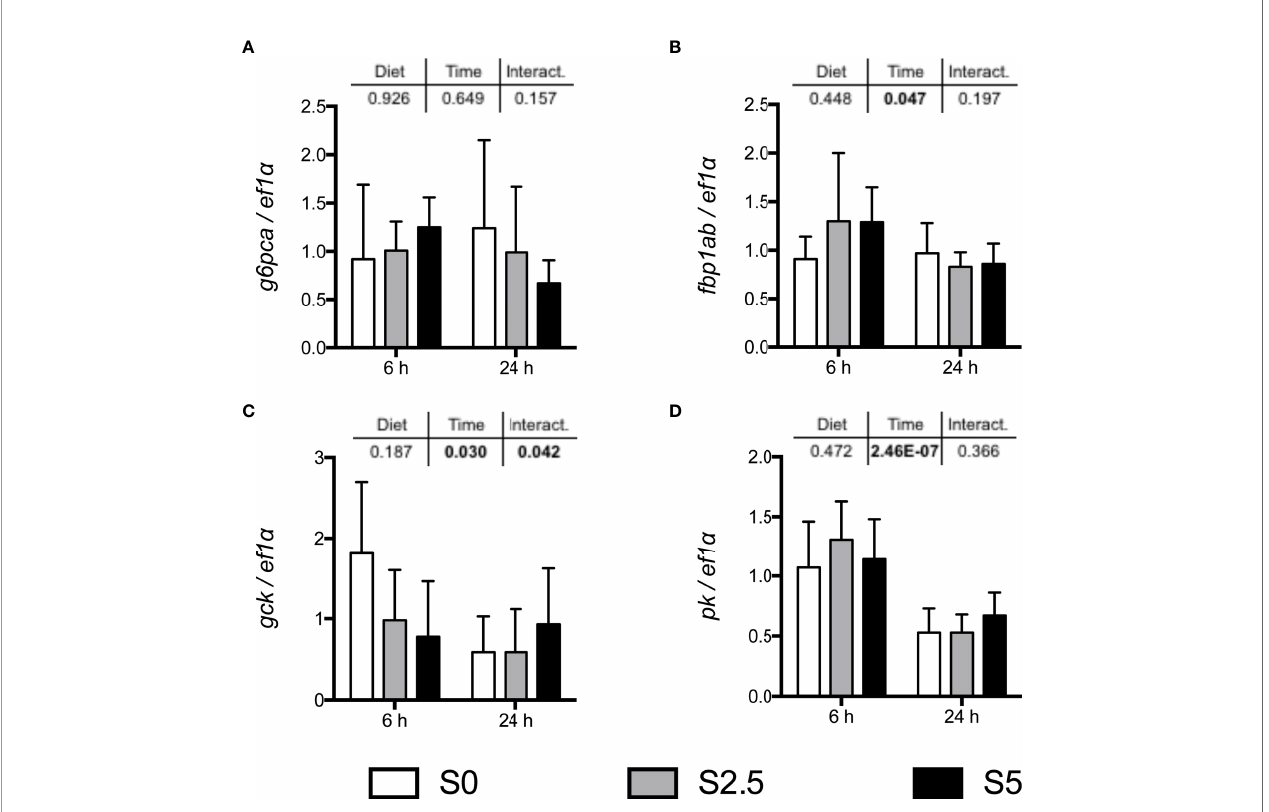
FIGURE 5 | mRNA levels of selected gluconeogenic enzymes (A) g6pca (glucose-6-phosphatase a), (B) fbp1ab (fructose-1,6-bisphosphatase with paralogs fbp1a and fbp1b ); and glycolytic enzymes (C) gck (glucokinase) and (D) pk (pyruvate kinase), in the liver of European seabass ( Dicentrarchus labrax ) fed with different levels of glycerol (0, 2.5, and 5%) for 6 weeks. Values are mean ± SD (n = 7). Signi fi cant differences were evaluated by two-way ANOVA (p < 0.05, values in